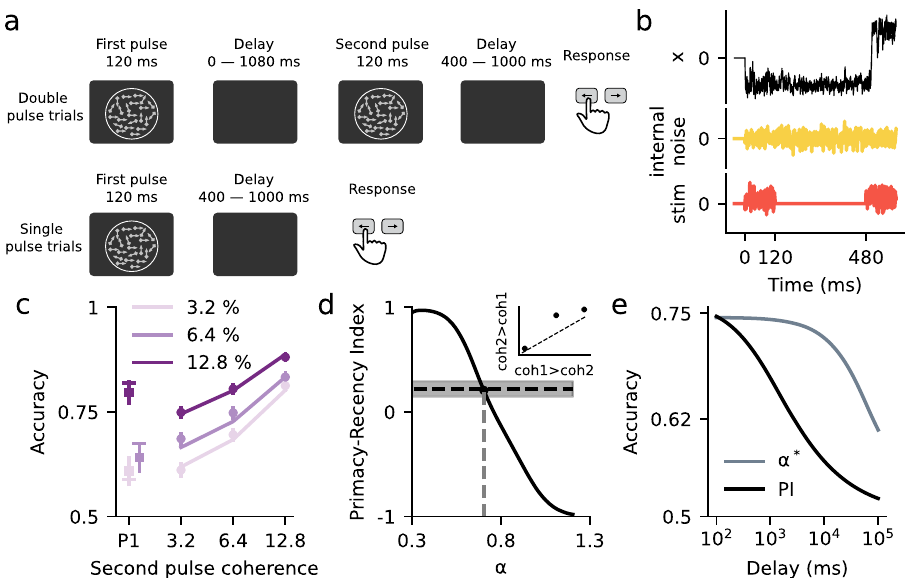
Fig. 7 The fl exible categorization regime accounts for the combination of two pulses of evidence during a working memory task. a Visual motion categorization experiment consisting of interleaved double pulse (top) and single pulse trials (bottom) 35,40 . On double pulse trials, the two motion pulses were separated by a variable delay (duration 0, 120, 360, or 1080 ms). Coherences were randomly selected from trial-to-trial. In two pulse trials, they could be different but the motion direction was always congruent ( N = 9). b Traces of the decision variable of the DWM (black), the internal fl uctuations (yellow), and the stimulus (orange) for an example double pulse trial. c Accuracy for single (squares) and two pulse trials (dots) versus the coherence of the second pulse observed in the data from 35,40 (dots) and the values obtained from the fi tted DWM (lines). Because accuracy in the experiment did not depend on delay length, dots show the average accuracy across all delays. Different colors represent different fi rst pulse coherences (see inset). Symbols show mean across subjects and error bars show 95% con fi dence intervals. d Primacy-recency index (PRI) for the DWM as a function of the barrier height ( c 2 ). The black dot marks the PRI for the fi tted parameter α * = 0.7. The horizontal line is the PRI computed from the psychophysical data (gray area 95% con fi dence interval). Inset: accuracy for two pulse stimuli in which coherence is larger in pulse 2 than in pulse 1 (i.e., coh2 > coh1) versus accuracy for the same pulses presented in the reverse order (i.e., coh1 > coh2). Consistent with the recency effect, accuracy is slightly better for coh2 > coh1 stimuli. e Accuracy as a function of the delay duration for DWM and for the Perfect Integrator. In the DWM, which used the fi tted parameter α * and σ I = 0.32 and σ = 0.40, the accuracy is independent of the delay up to 1 s. In contrast, for the same internal noise σ S I , the accuracy of the perfect integrator decreases continuously for all